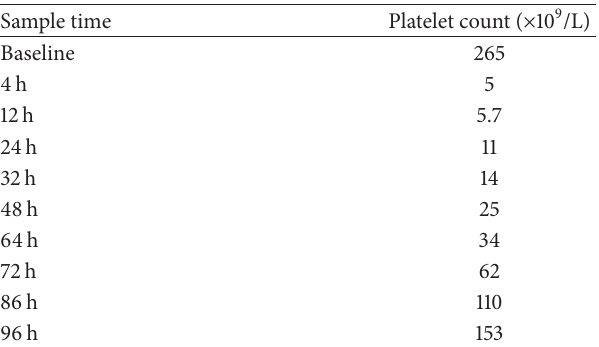
Table 1: Platelet counts at baseline and after the percutaneous coronary